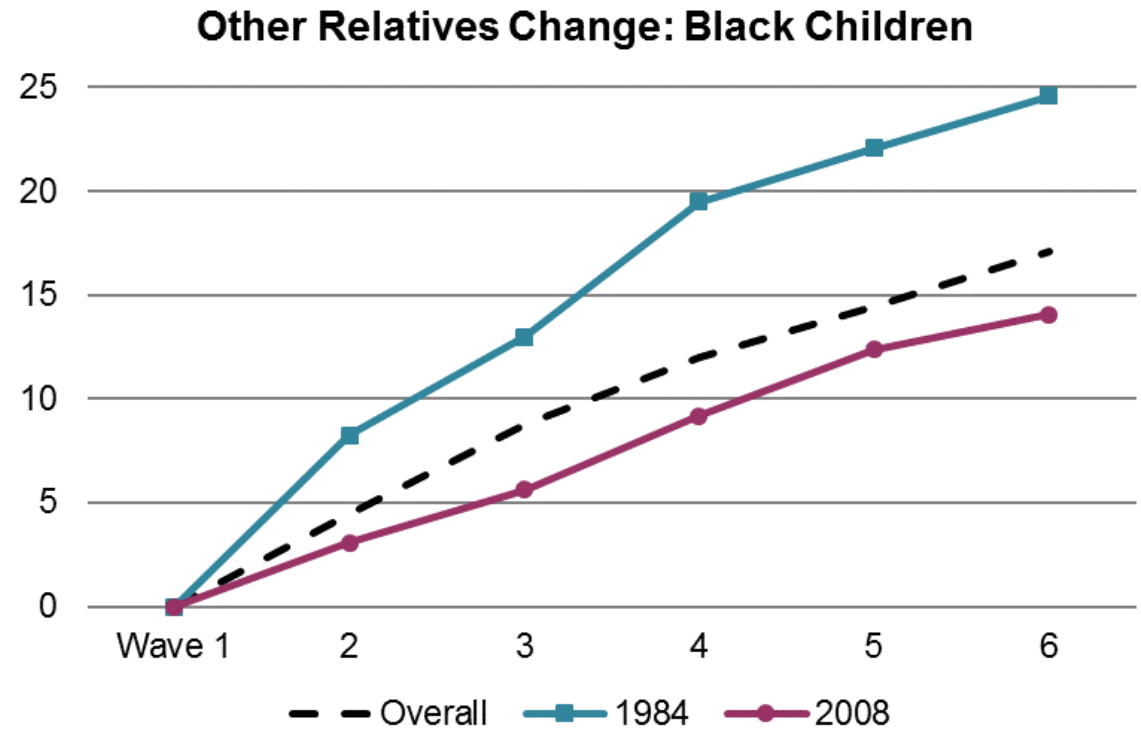
Figure 7: Weighted cumulative percent of black children (by panel) exposed to other relatives leaving and joining